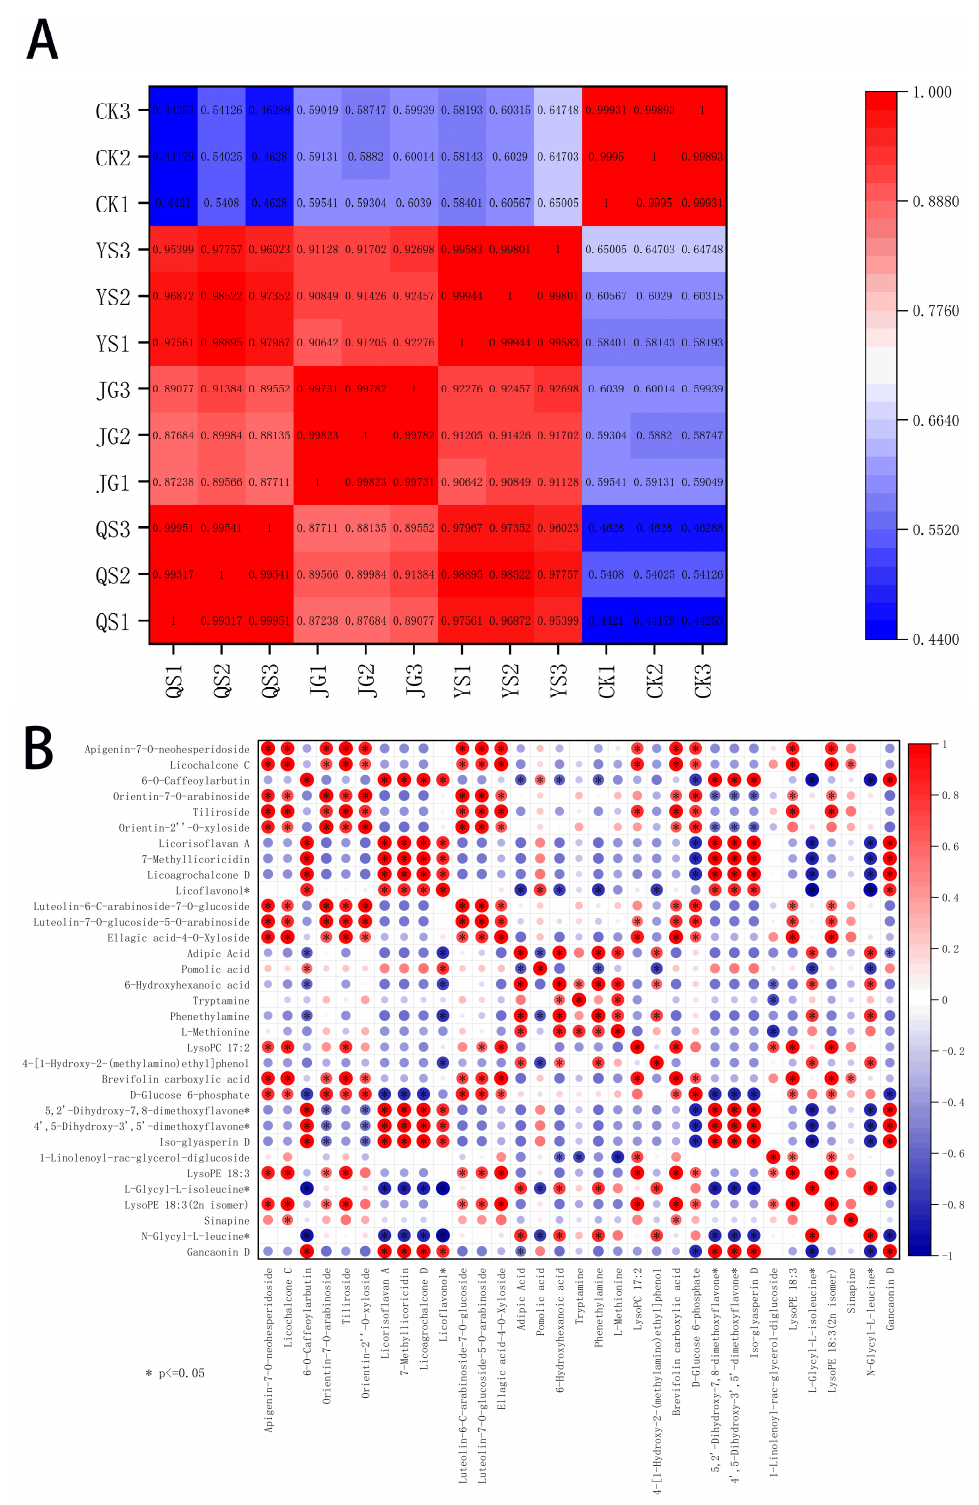
Figure 7. ( A ) Pearson correlation coefficient heatmap of the samples screened. ( B ) Pearson correlation analysis heatmap between the 33 differential metabolites